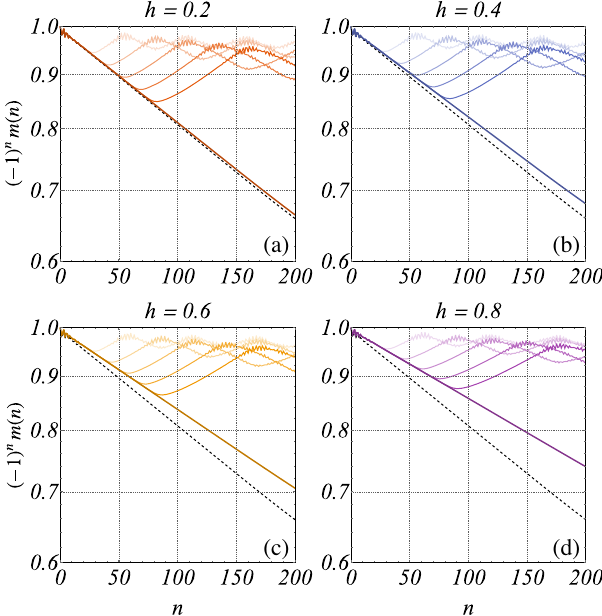
FIG. 6. Log-linear plots of the order-parameter time evolution under the Floquet dynamics induced by K π and different values of h . Thick lines are the iTEBD data, which are compared with ED results for a finite system with different sizes L ¼ 10 , 15, 20, 25, 30 (shaded lines, from lighter to darker). Dashed black lines are the results for h ¼ 0 , and they are plotted for